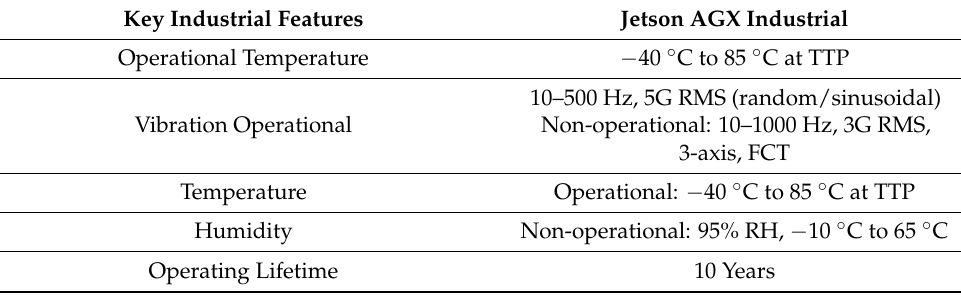
Table 6. Jetson Xavier AGX Industrial technical